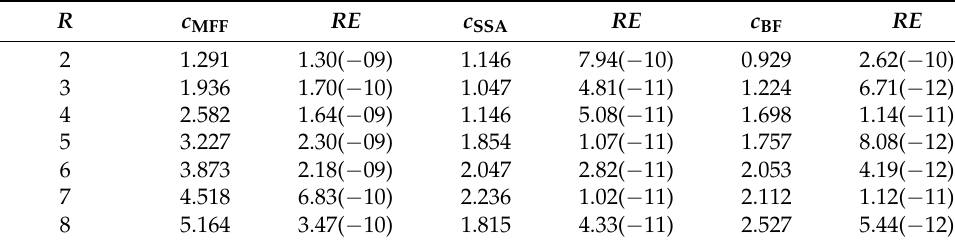
Table 1. The relative errors of the improved RBFCM with different R .